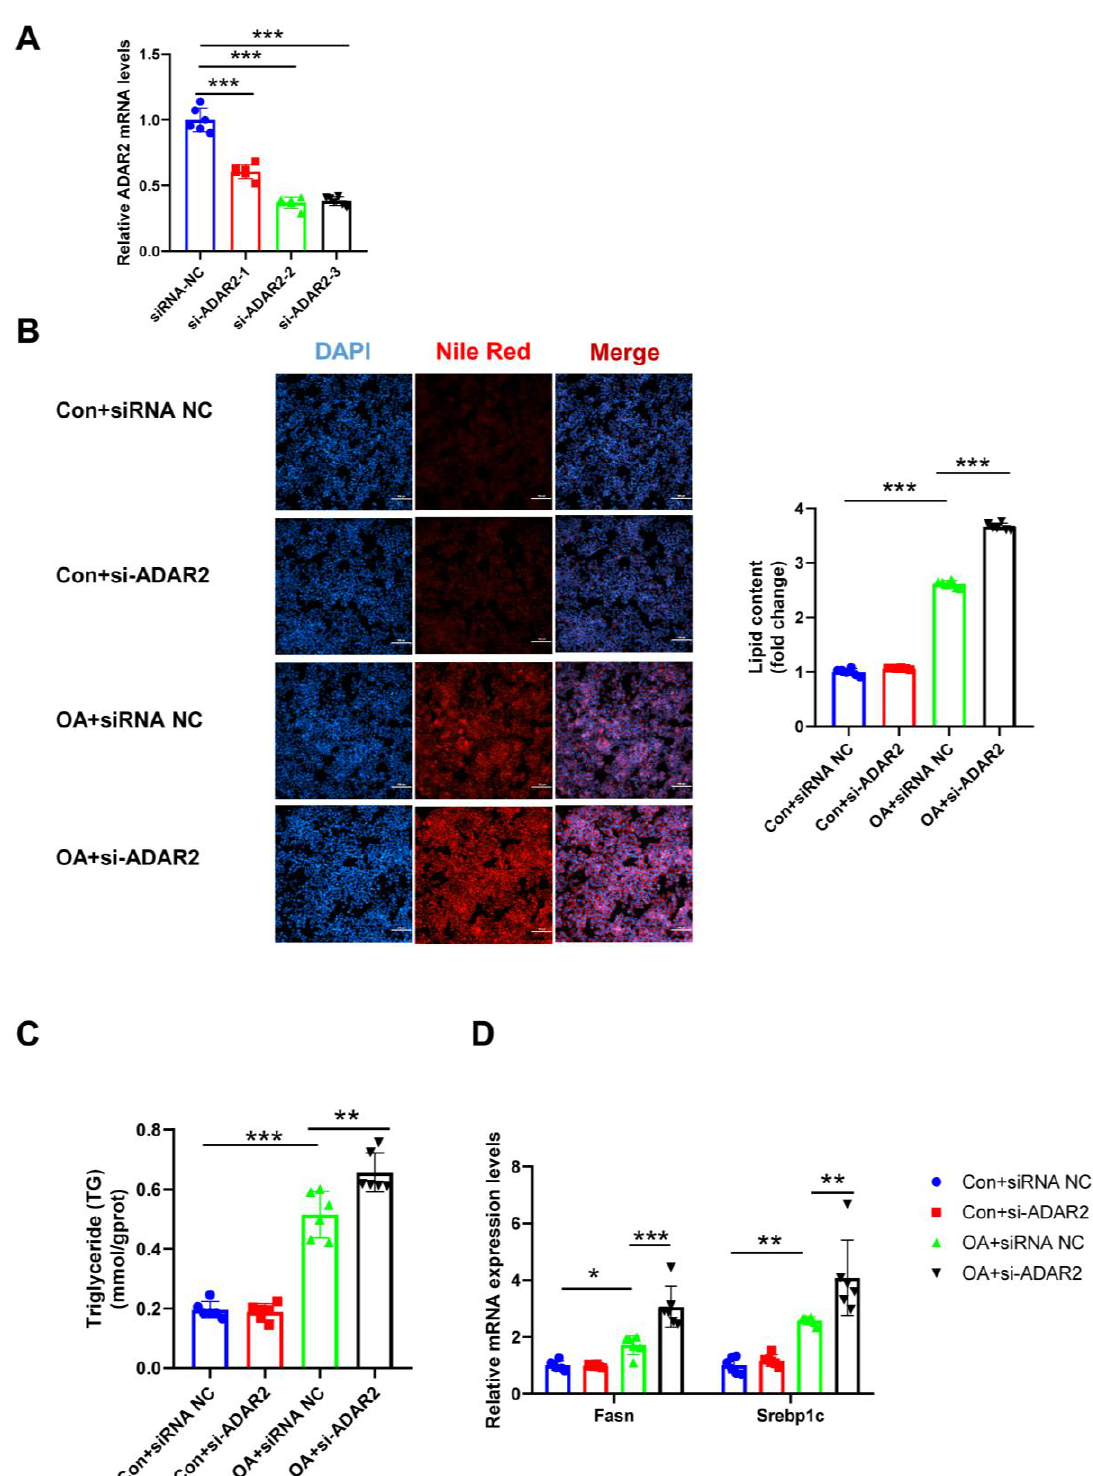
Figure 4. ADAR2 knockdown accelerates lipogenesis in hepatocytes. ( A ) The mRNA levels of ADAR2 relative to GAPDH were analyzed by qRT-PCR after transfection with ADAR2-siRNA in HepG2 cells. ( B ) The lipid content of HepG2 cells was determined by Nile Red staining. ( C ) The TG levels of HepG2 cells. ( D ) The mRNA levels of lipogenesis-related genes (Fasn and Srebp1c) relative to GAPDH were analyzed by qRT-PCR. * p < 0.05, ** p < 0.01, *** p < 0.001; n = 6. OA, oleic acid; TG, triglyceride; ADAR2, adenosine deaminases acting on RNA 2; Fasn, fatty acid synthase; Srebp1c, sterol regulatory element binding protein-1c. Scale bar = 100 µ